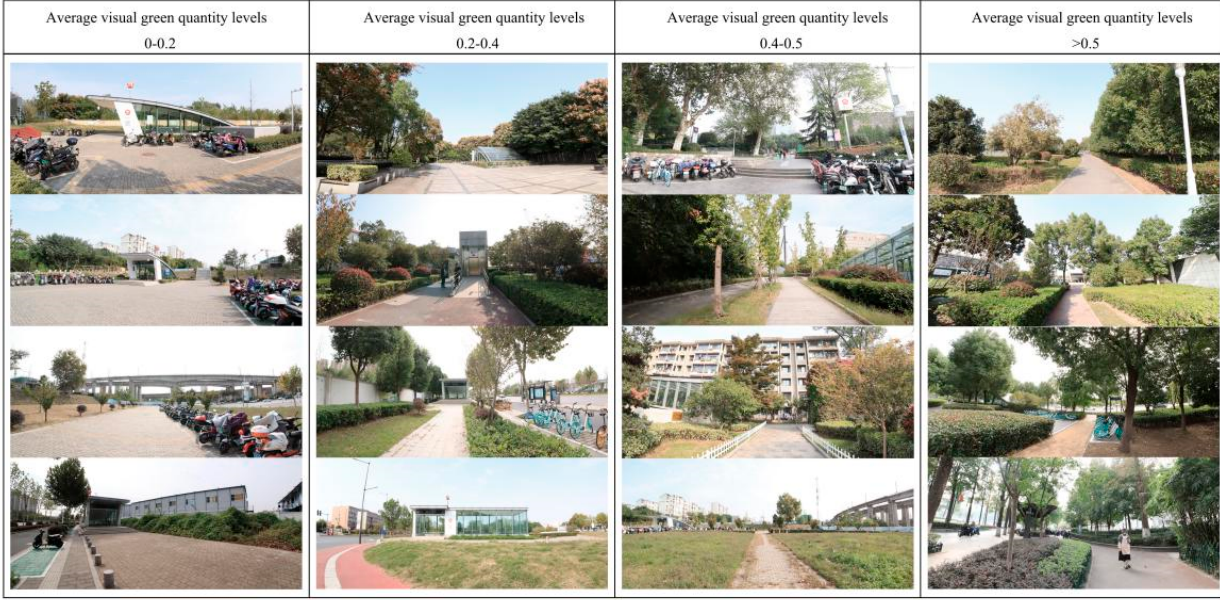
Figure 7. Examples of acquisition results of different average visual green quantity levels.